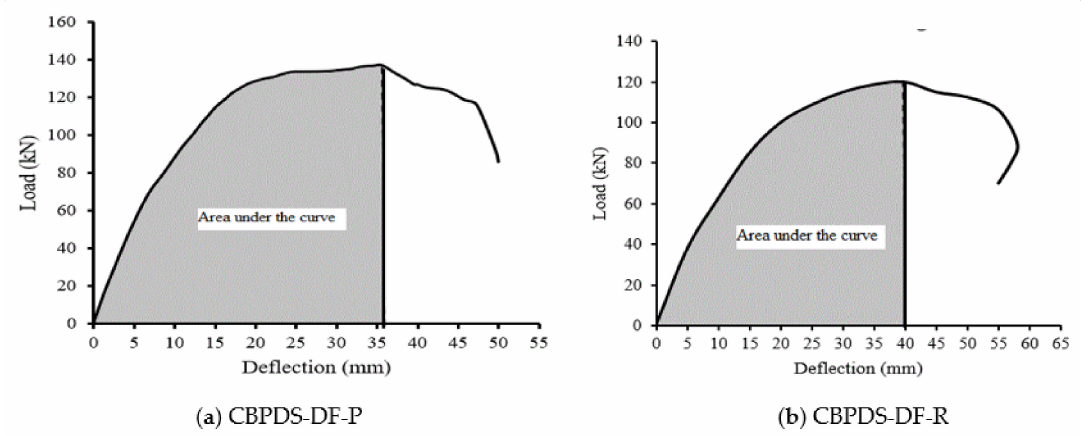
Figure 19. Typical load vs. mid-span deflection curves for estimating the EA index.